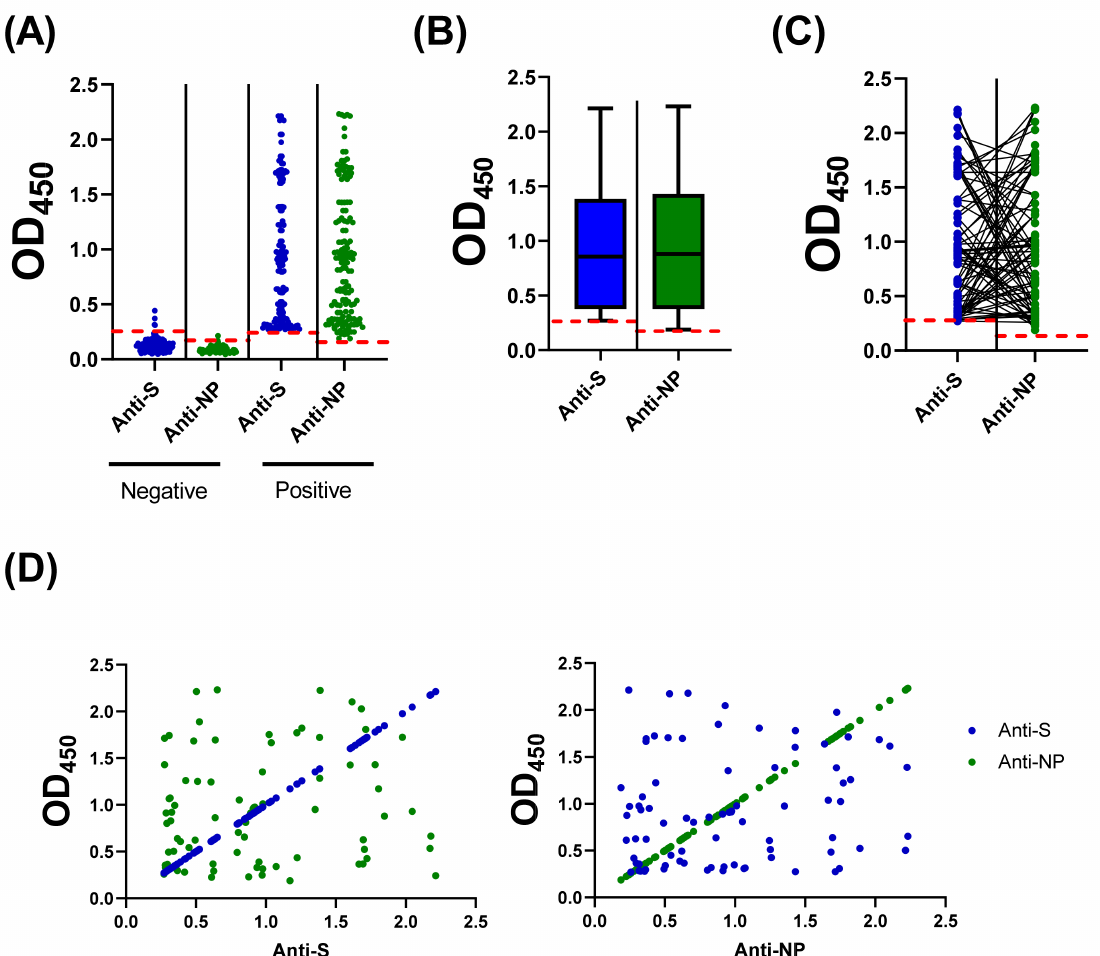
Figure 4. Compairson and correlation between COVID-19 NP and S IgG ELISAs. ( A ) Optical density values at 450 nm (OD 450 ) for all negative and positive samples by MN assay using previously develpoed S-based ELISA and the NP-based ELISA protocol optimized in this study. ( B ) Data distribution of positive samples. Boxes: 25th to 75th percentile range; black line: median; whiskers: Min and Max. ( C ) OD 450 values for each sample as obtained from S- and NP-based ELISAs. ( D ) Non-significant correlation between S- and NP-ELISAs; r 2 = 0.01849, p value = 0.226.